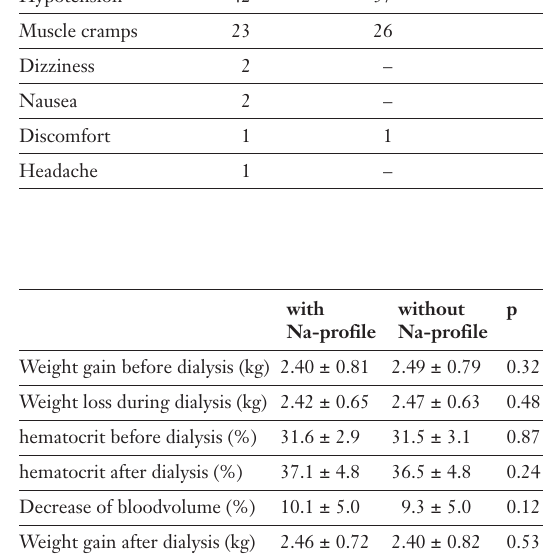
Symptoms occurring during dialysis with versus without Na- profile (all symptoms not significantly different by Fisher’s exact test).